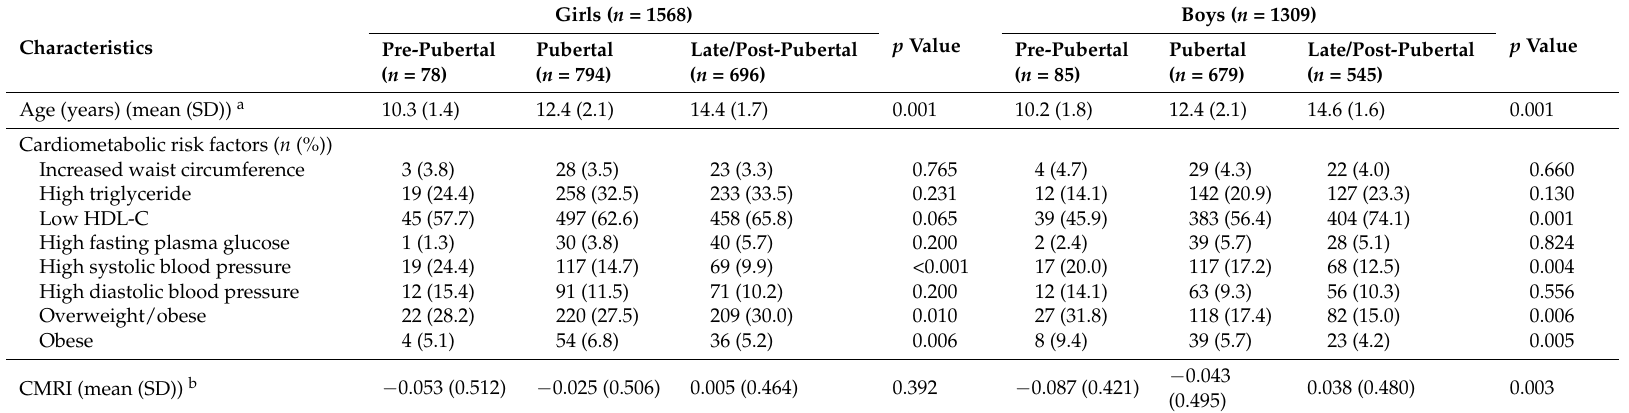
Table 2. Association between pubertal stage and cardiometabolic risk factors by